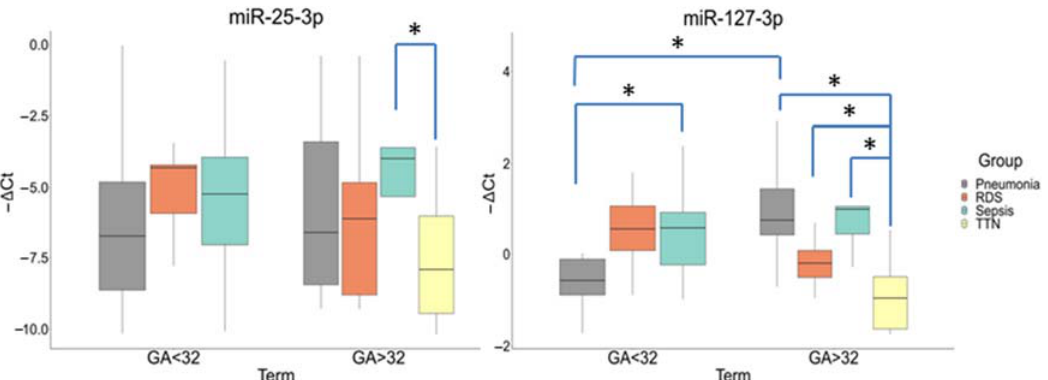
Figure 4. Comparative analysis of the expression for miR-25-3p and miR-127-3p in blood plasma from newborns with perinatal outcomes at before (<32) and after (>32) gestational ages (GA). *: significance level p ≤ 0.05 when compared groups with each other. The box diagram shows the medians of − ∆ Ct values (relative quantification data), the first and third quartiles, and the edges of the statistically significant sample, while the dots denote the emissions.